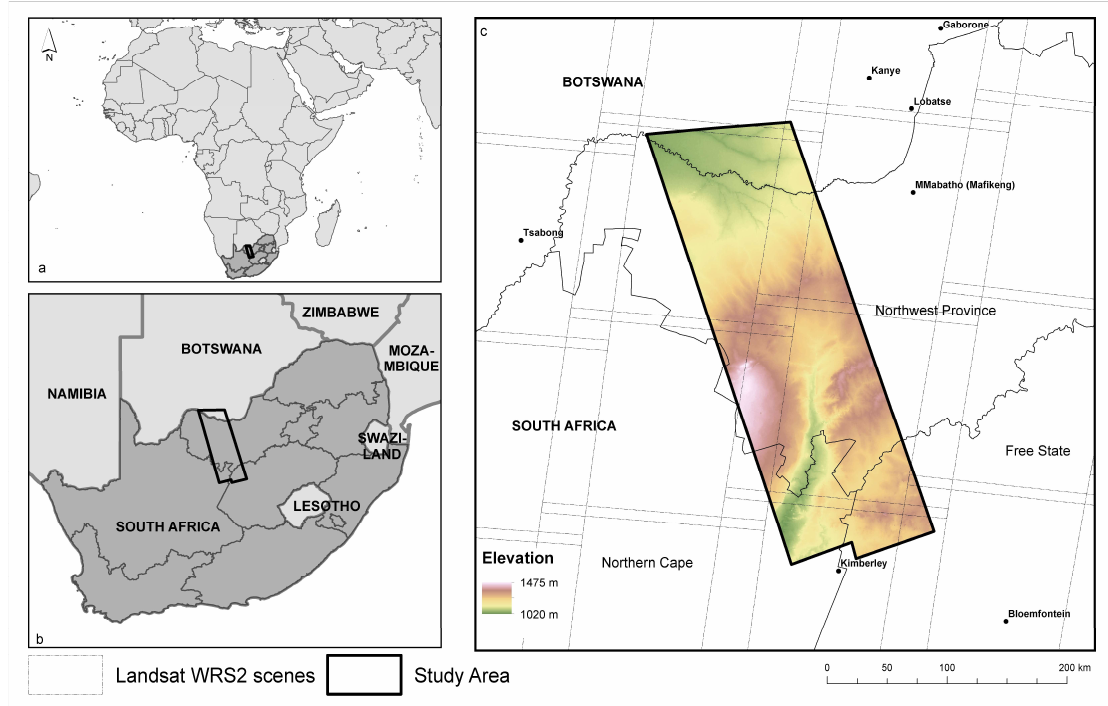
Figure 1. The location of the study area in: ( a ) Africa, and ( b ) southern Africa. ( c ) The elevation within the study area.